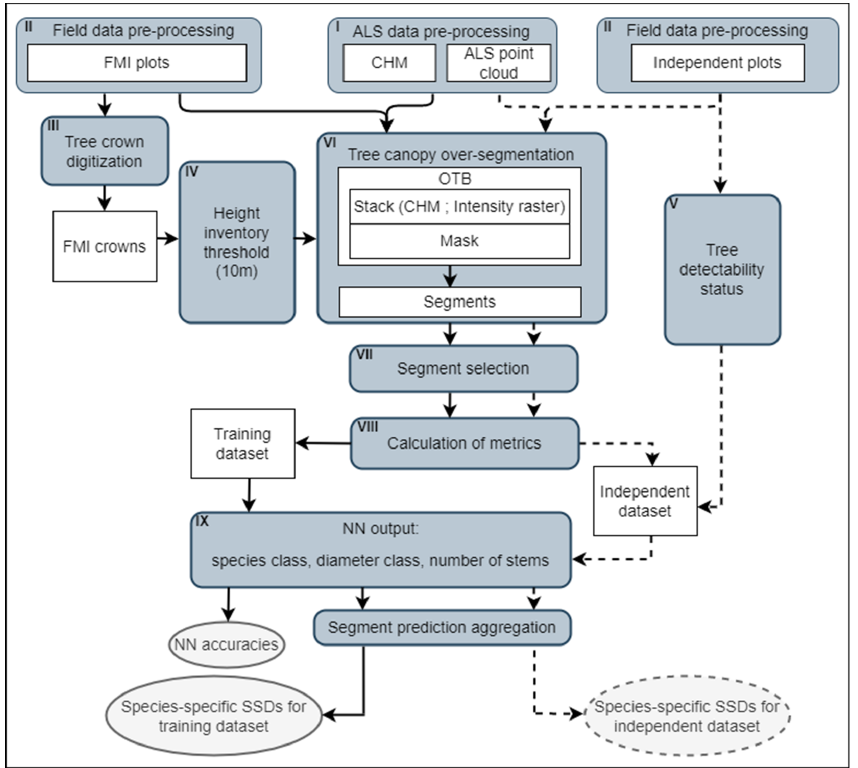
Figure 3. Workflow of the developed method. Square white boxes represent data or intermediate results, while rounded grey boxes represent processing steps. Solid arrows indicate successive steps, while dashed arrows show robustness test steps. CHM, canopy height model; NN, neural network; OTB, Orfeo ToolBox.